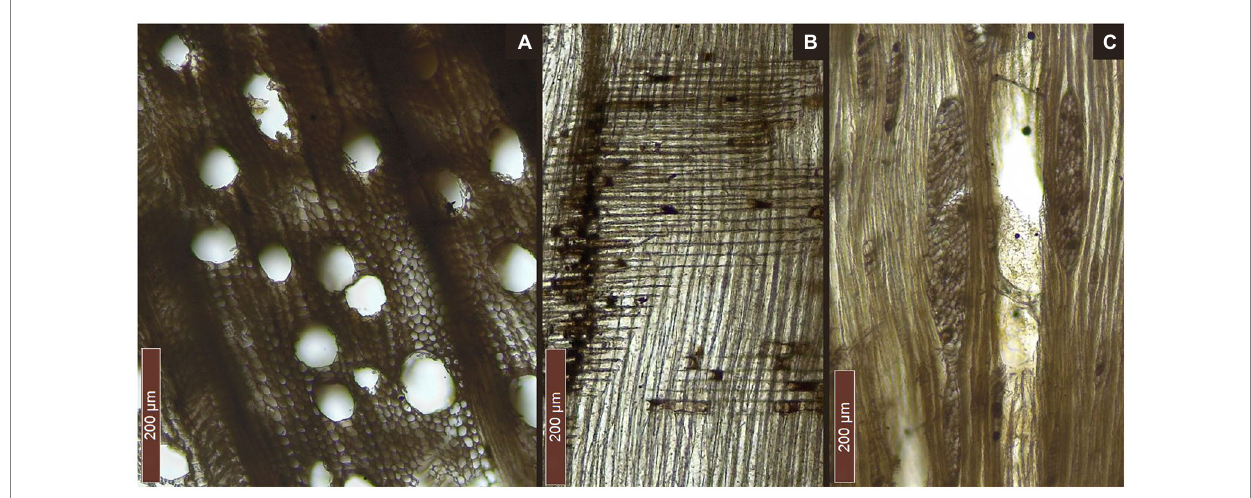
FIGURE 4 Diagnostic sections of Fagus cf. sylvatica (Marmotta 5): (A) transversal section, (B) radial section, and (C) tangential